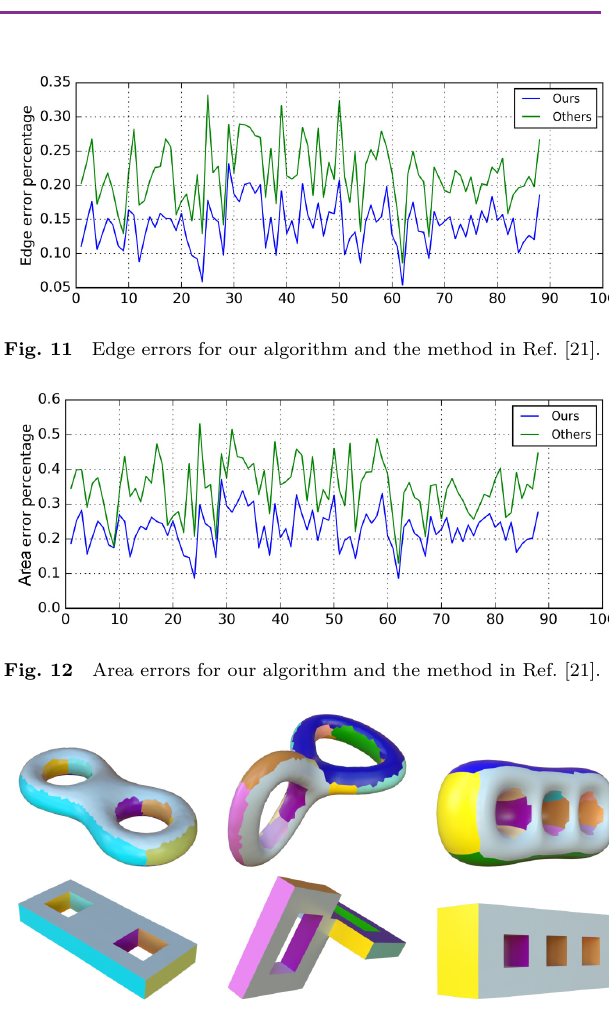
Fig. 13 Models of high genus and their polycube shapes.